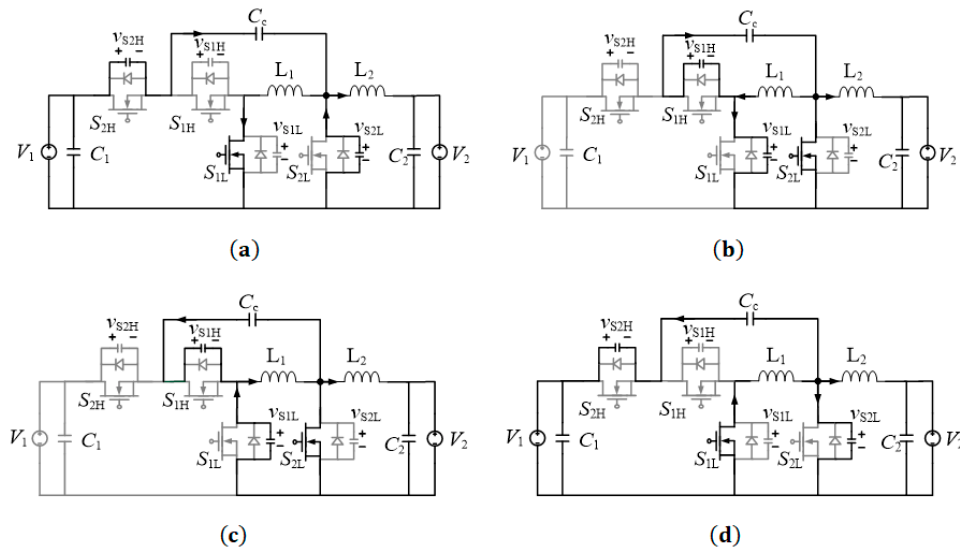
Figure 4. Resonant periods of the TCM high-voltage-gain DC–DC converter in the forward (cid:48) (cid:48) (cid:48) (cid:48) direction: (𝐚) [t (cid:2869) ,t (cid:4593) (cid:2869) ] ; (𝐛) [t (cid:2870) ,t′ (cid:2870) ] ; (𝐜) [t (cid:2871) ,t (cid:4593) (cid:2871) ] ; (𝐝) [t (cid:2872) , t′ (cid:2872) ] . ( a ) [ t ] ; ( b ) [ t ] ; ( c ) [ t ] ; ( d ) [ t ] 2 ,t 2 3 ,t 3 1 ,t 1 4 ,t 4